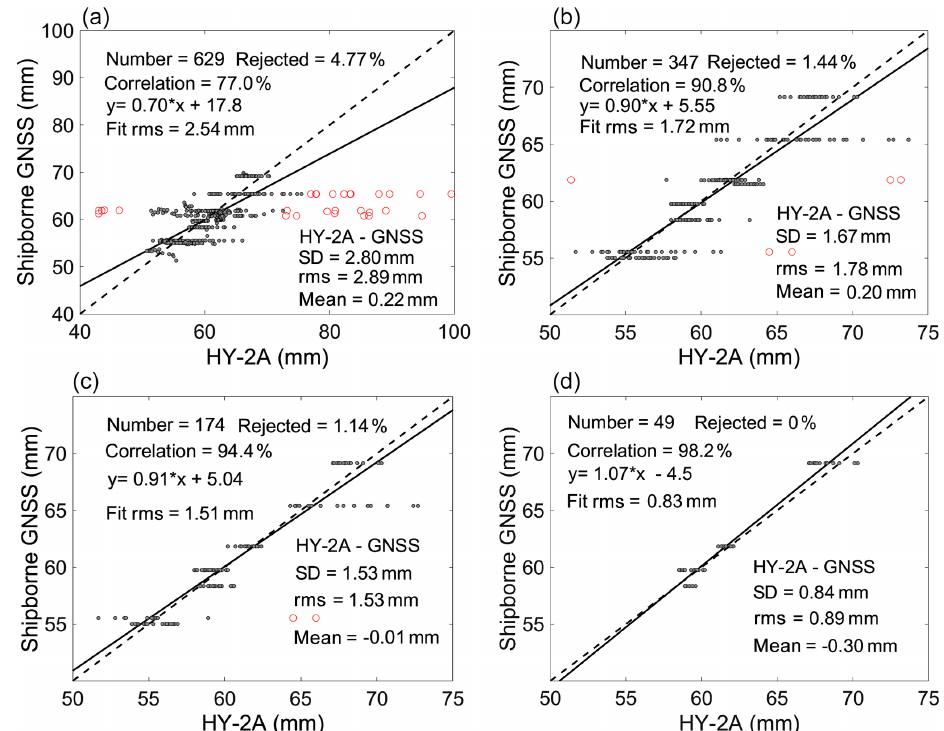
Figure 7. PWV comparison between HY-2A CMR and shipborne GNSS for crossover points with a distance threshold of (a) 200km, (b) 150km, (c) 100km, and (d) 50km. The red circles are for outliers, and the linear fit result is presented as a solid line with its reference in dash line. For each panel, the linear fit is shown in the upper left, and the comparison statistics are shown in the bottom